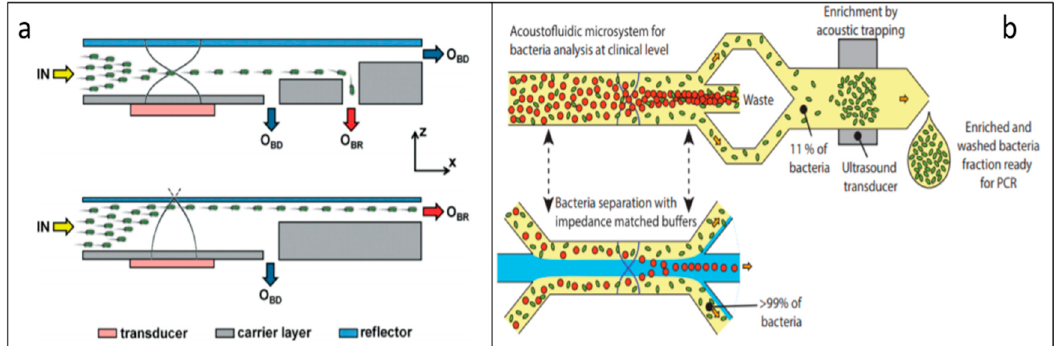
Figure 8. ( a ) Separating bacteria from water for water analysis using an optimized thin-reflected acoustic resonator. Reprinted with permission from reference [116]. ( b ) E. coli bacteria are separated from high concentrated blood samples and enriched for clinical sepsis diagnosis using polymerase chain reaction (PCR). Reprinted with permission from reference [115].